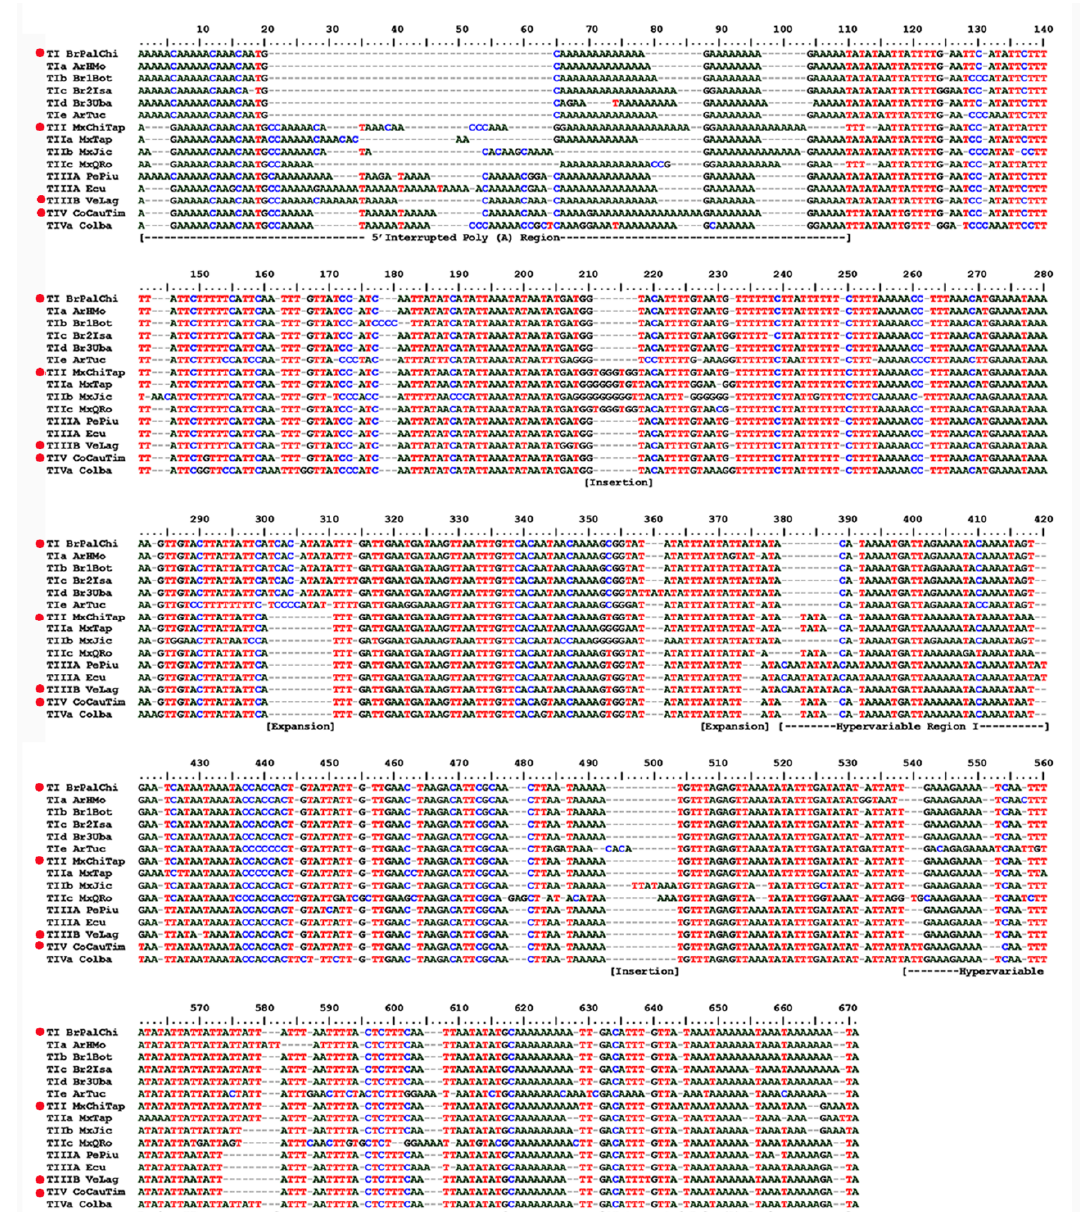
Figure 3. Alignment of representative ITS1 sequences of the AF complex. Sequences are identified as TI to TIV, and the variants are labelled as TIa to TIe, and TIVa. Underneath the alignment, special landmarks of the sequences are indicated. The red dots indicate Sutton et al.’s sequences [32].